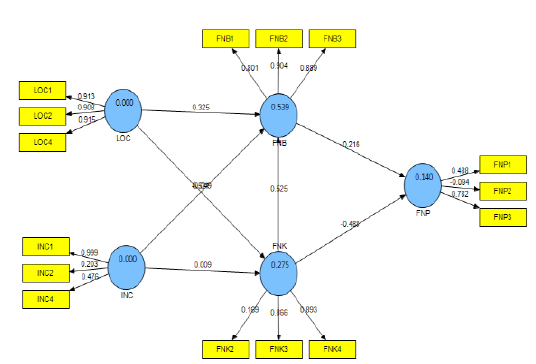
Figure 3. Path Coefficients and Factor Loading